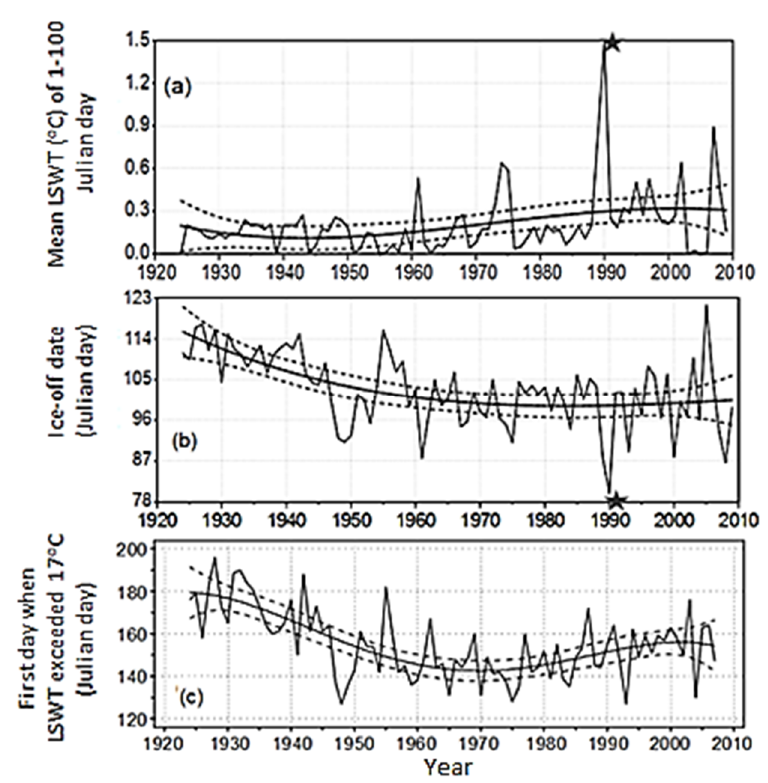
Figure 2. Long-term changes of selected lake surface water temperature (LSWT) parameters in Lake Peipsi: ( a ) mean LSWT ( ◦ C) of 1–100 Julian days; ( b ) ice-o ff date-first Julian day when LSWT exceeded 1 °C; and ( c ) first day when LSWT exceeded 17 °C (Julian day). Cubic regression curves predict the parameter values for different times (continuous line). The 95% confidence limits for predictions are shown by dashed lines. The regressions presented by lines are significant (p < 10 −6 ). The year of vendace collapse is marked with “ (cid:70) ”.